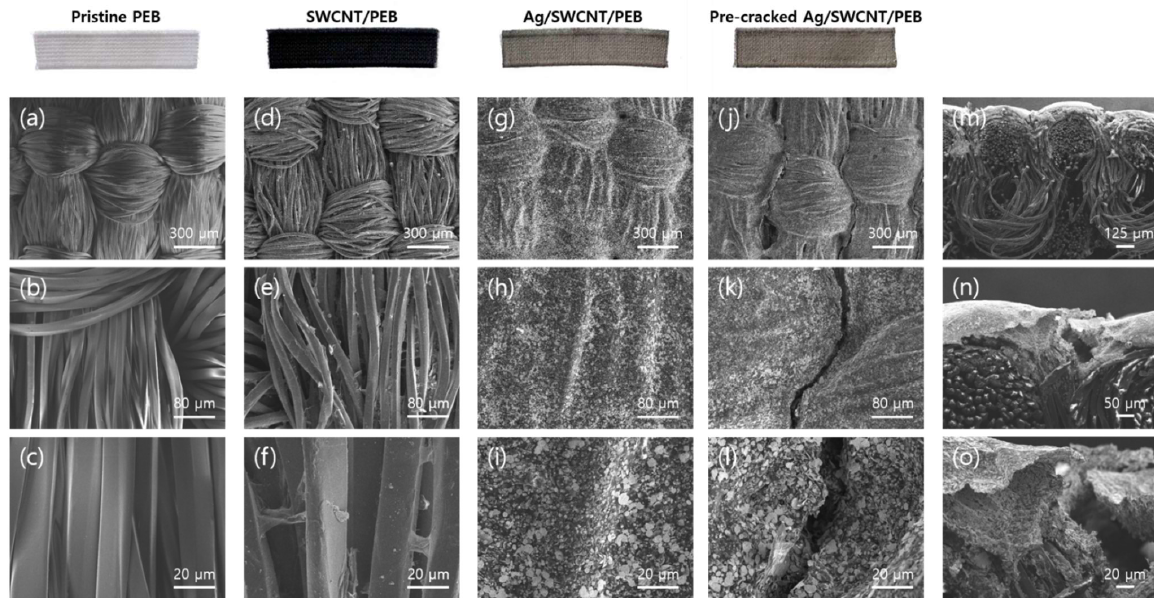
Figure 2. Top-view SEM images of pristine PEB at 300 um ( a ); 80 um ( b ); 20 um ( c ); SWCNT/PEB at 300 um ( d ); 80 um ( e ); 20 um ( f ); Ag/SWCNT/PEB at 300 um ( g ); 80 um ( h ); 20 um ( i ); Pre-cracked Ag/SWCNT/PEB at 300 um ( j ); 80 um ( k ); 20 um ( l ); Cross-sectional SEM images of pre-cracked Ag/SWCNT/PEB at 125 um ( m ); 50 um ( n) ; 20 um ( o ).